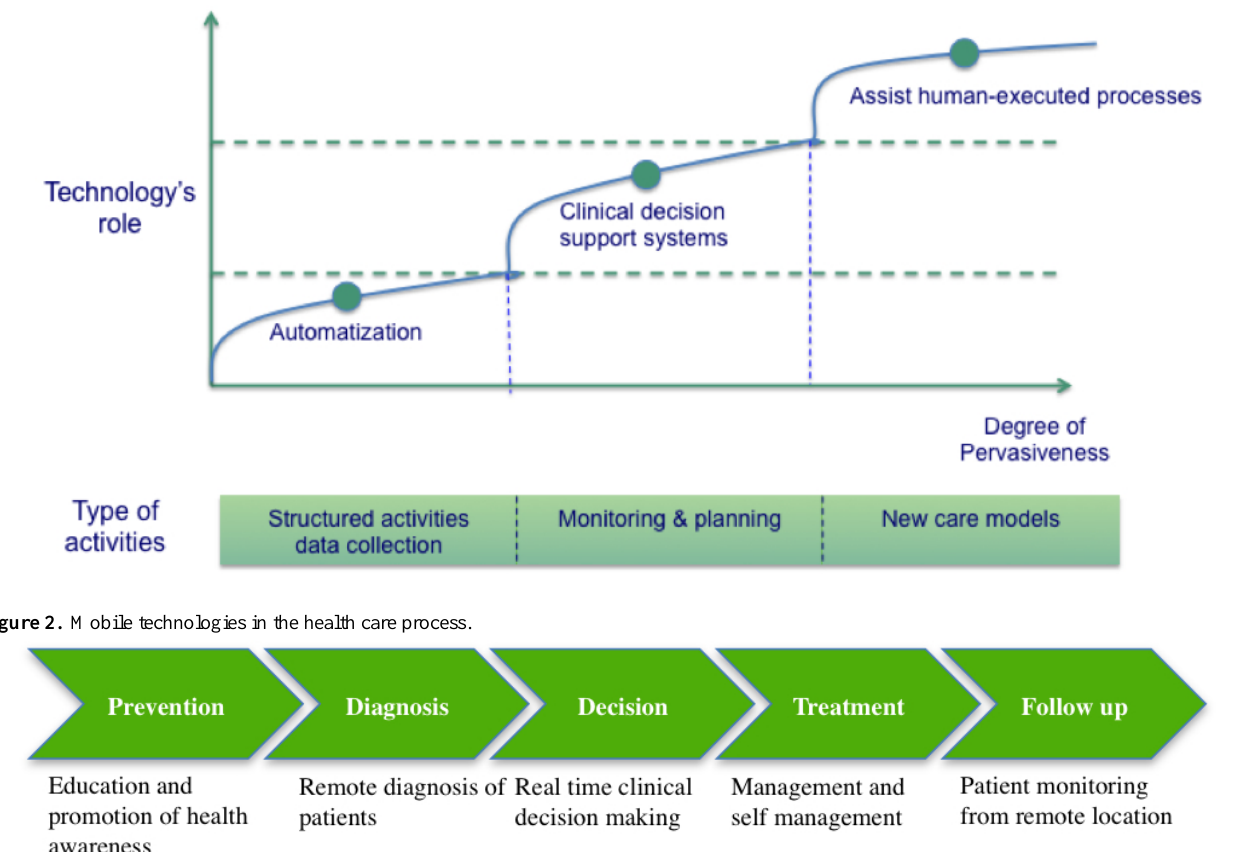
Figure 1. The role of mHealth.